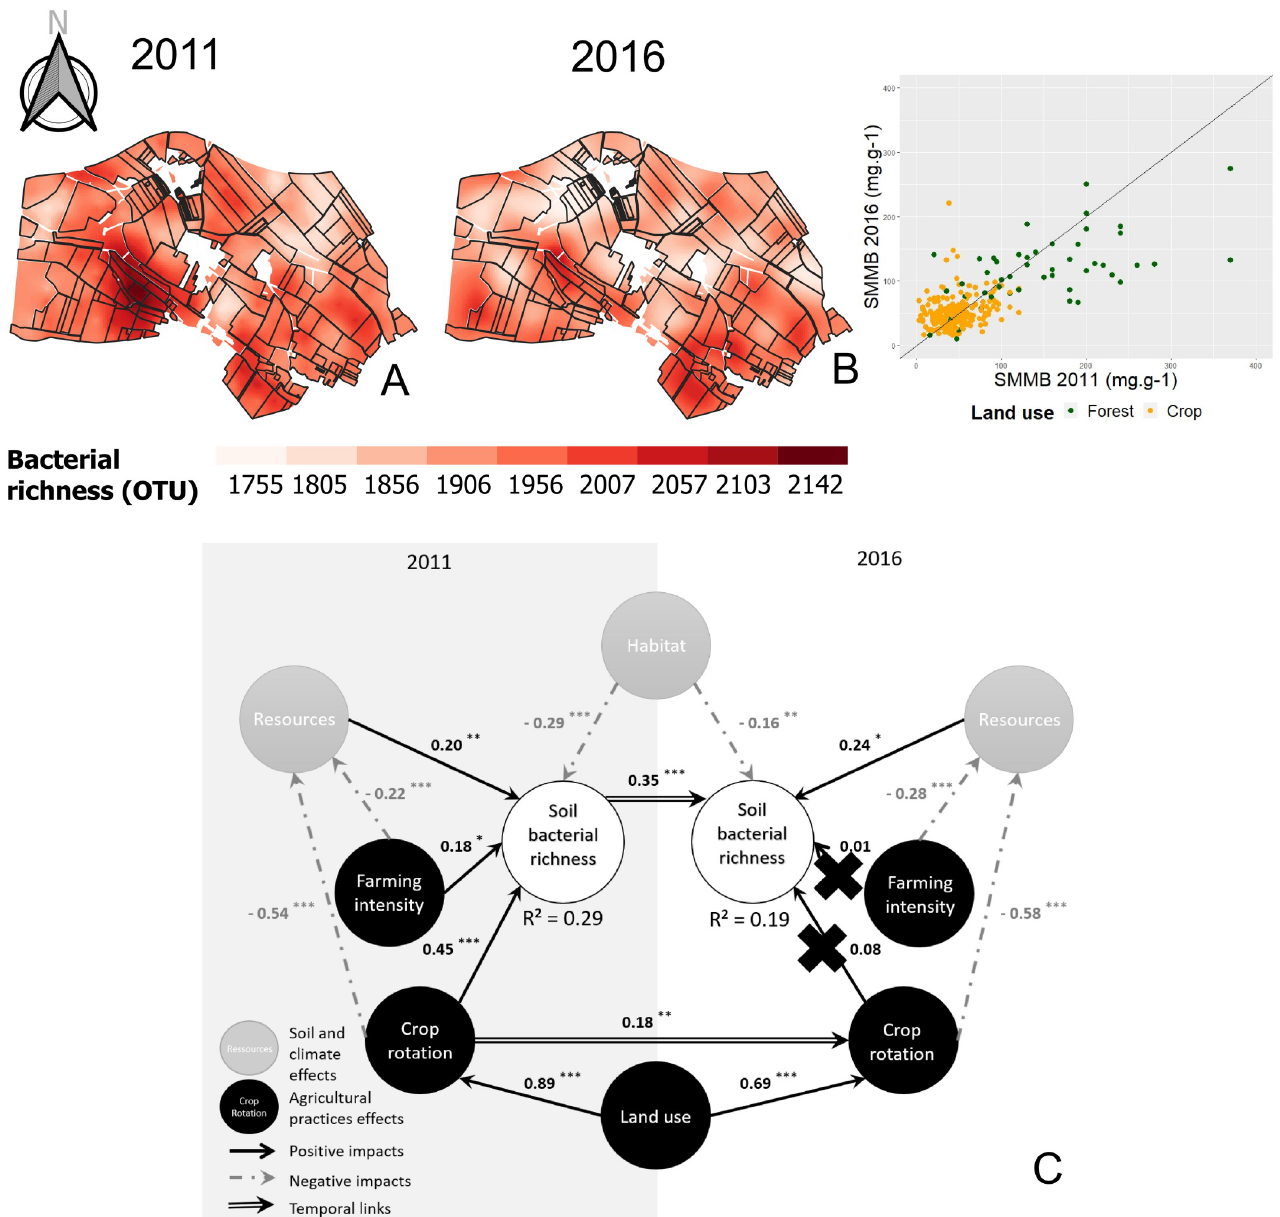
Fig 6. Interpolated mapping of soil bacterial richness in 2011 (A) and 2016 (B), and complete path model (C). In the interpolated maps, the color scale is the same for the two sampling campaigns and indicates the extrapolated values. The ranges of the models were 349.00 m (A) and 101.35 m (B). The scatter plot on the right of the maps corresponds to the variation of the parameter in 2016 depending on the same parameter in 2011. Green dots, forest plots; orange dots, farmed plots. Line, equation y = x. Concerning the complete path model for biomass analysis (C), circles correspond to the latent variables (LVs), with anthropogenic LVs in black and ecological LVs in gray. Path coefficients were computed from regressions and allowed us to estimate the strength and direction of relations between LVs. Black arrow, positive impact; gray arrow, negative impact; double arrow, temporal impact. Significant impacts were evaluated based on a t-test: P < 0.1; � : P < 0.05; �� : P < 0.01; ��� : P < 0.001). Crosses indicate inaccurate path coefficients according to a bootstrap